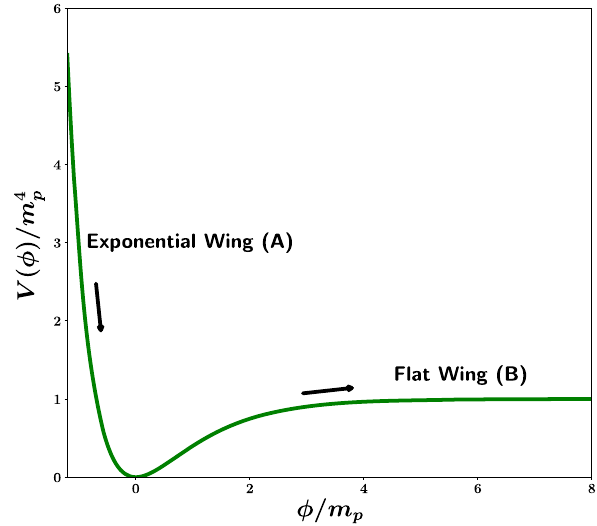
Fig. 6 This figure schematically illustrates the Starobinsky-type potential (33) with λ = 1. The main features of this potential are: the exponential wing for λ | φ | (cid:5) m p ( φ < 0), the flat wing for λφ (cid:5) m p , and a minimum at φ = 0, near which V ∝ φ 2